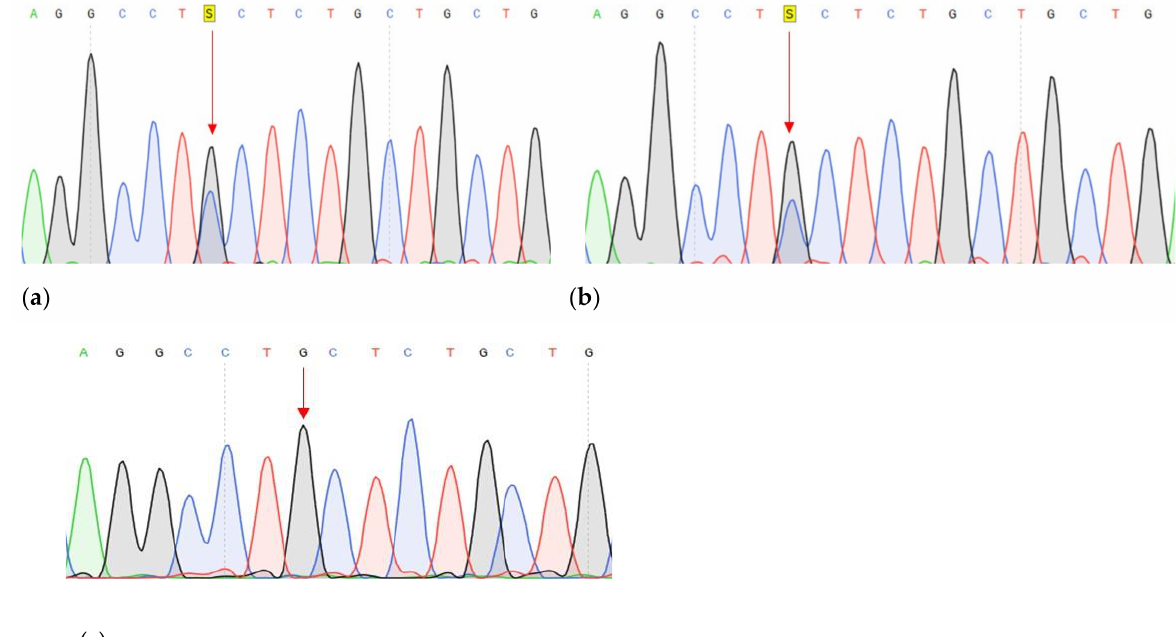
Figure 5. Fragments of the DNA sequence with the c.G1874C variant in the FANCA gene. ( a ) DNA sample with a change, isolated from the tumor tissue of a patient with 1 GC; ( b ) DNA sample with a change isolated from normal tissue of a 1GC patient; ( c ) Control DNA sample without change.